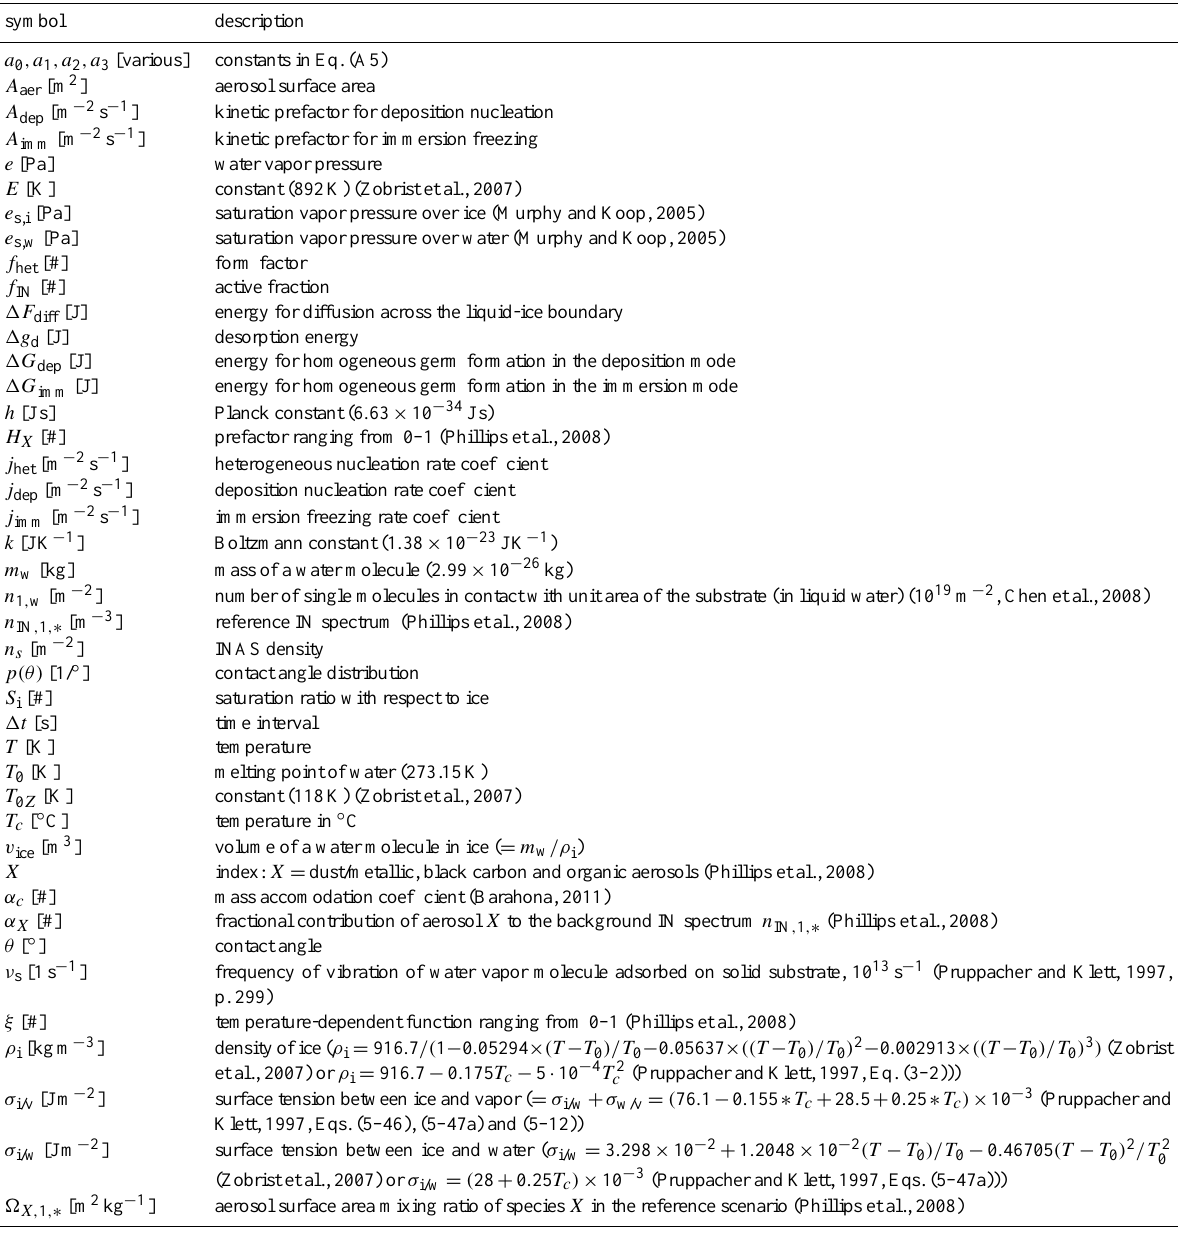
Table A1. List of